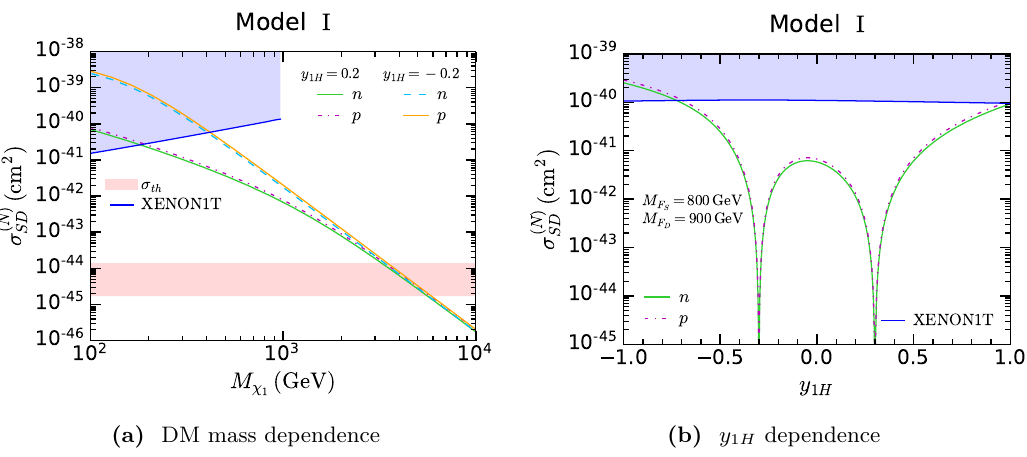
Figure 4. The DM-nucleon SD scattering cross sections as functions of (a) the DM mass M χ (b) y 1 H . The rest of the parameters are fixed as per in figure 2. The blue shaded area is excluded by the XENON1T experiment [173]. The horizontal red band represents the threshold cross section for neutron obtained in refs. [128, 130], σ th ’ [1 . 7 × 10 − 45 , 1 . 4 × 10 − 44 ] cm 2